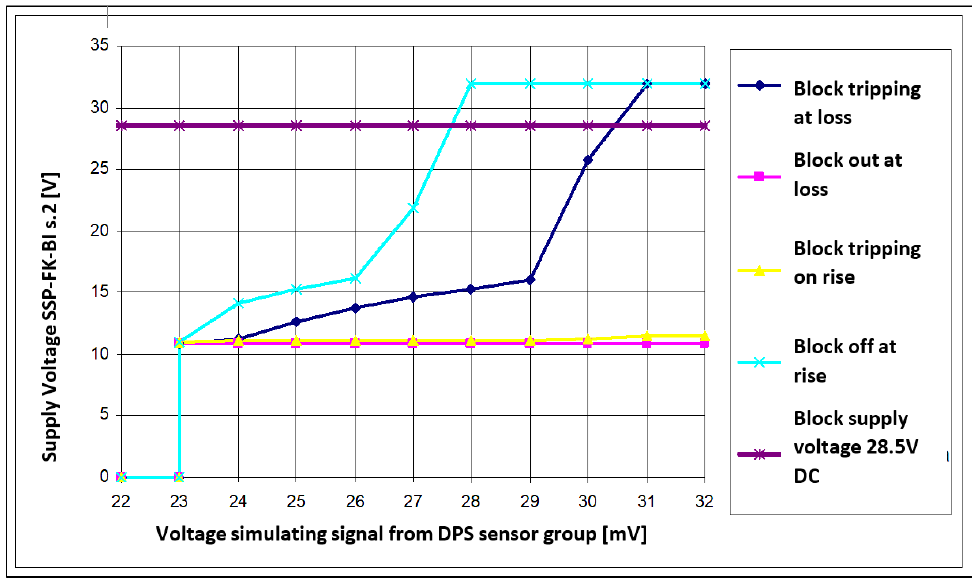
Figure 14. Actual trip and hold − up characteristics of SSP − FK − BI block.